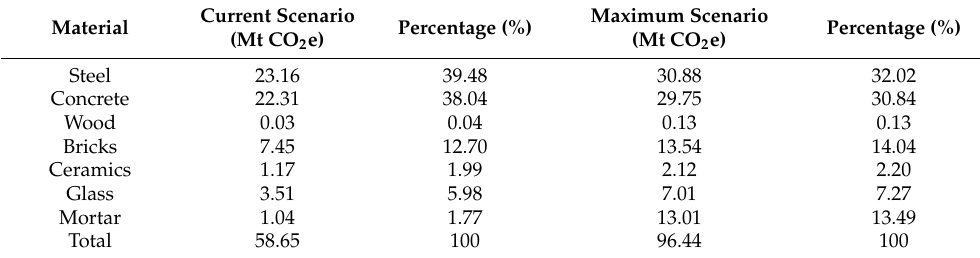
Table 5. Comparison of the carbon reduction potential of different recycling materials under two scenarios in Jiangsu Province in 2020.